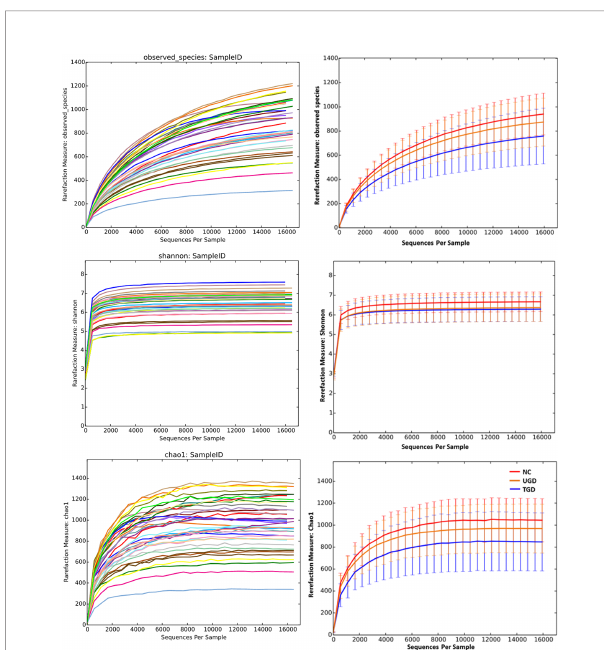
FIGURE 3 | Rarefaction curves of the Chao1 and Shannon indexes among the three groups. The abscissa represents the total number of randomly selected sequences in each sample, and the ordinate represents the number of OTUs observed at the corresponding depth.